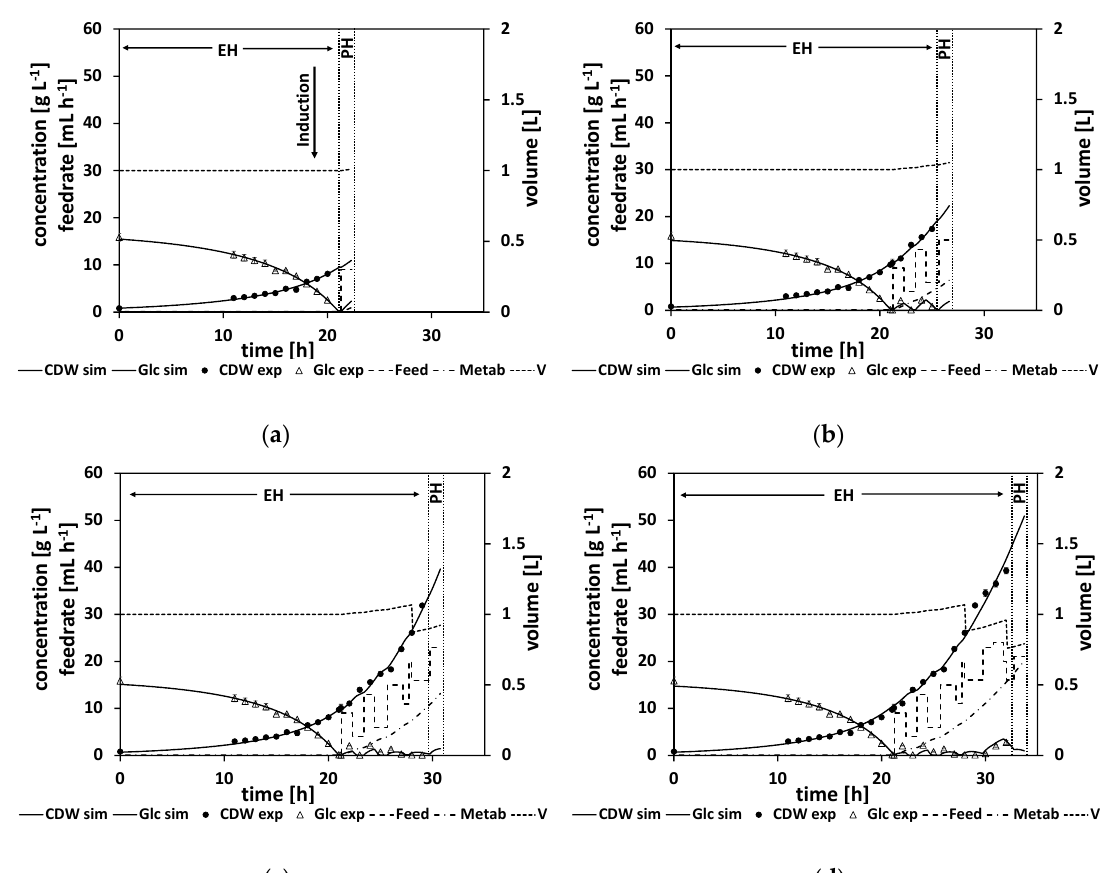
Figure 9. Time course of the glucose and biomass concentration for fed-batch 4. Left side of the vertical dotted lines indicates the estimation horizon (EH): symbols mark samples, the samples were measured as three technical replicates, the lines mark adapted the simulated cultivation course (Model B + ), the dashed line shows the calculated feed profile, the dotted line marks the simulated reactor volume. Between the vertical dotted lines indicating the prediction horizon (PH): the dashed line shows the optimized feed profile, the lines mark the extrapolated cultivation course, the dotted line marks the simulated reactor volume. ( a ) Prediction of the starting time point for the feed and the calculation of the optimized first feed rate with extrapolation starting time point τ = 21 h. ( b – d ) Calculation of the optimized feed rate for τ = 25.66 h, τ = 29.75 h, and τ = 32.75 h. For the parameter estimation results and the feed optimization results, see Tables A16–A18. For the model equations, see Table A15 or Table 2.